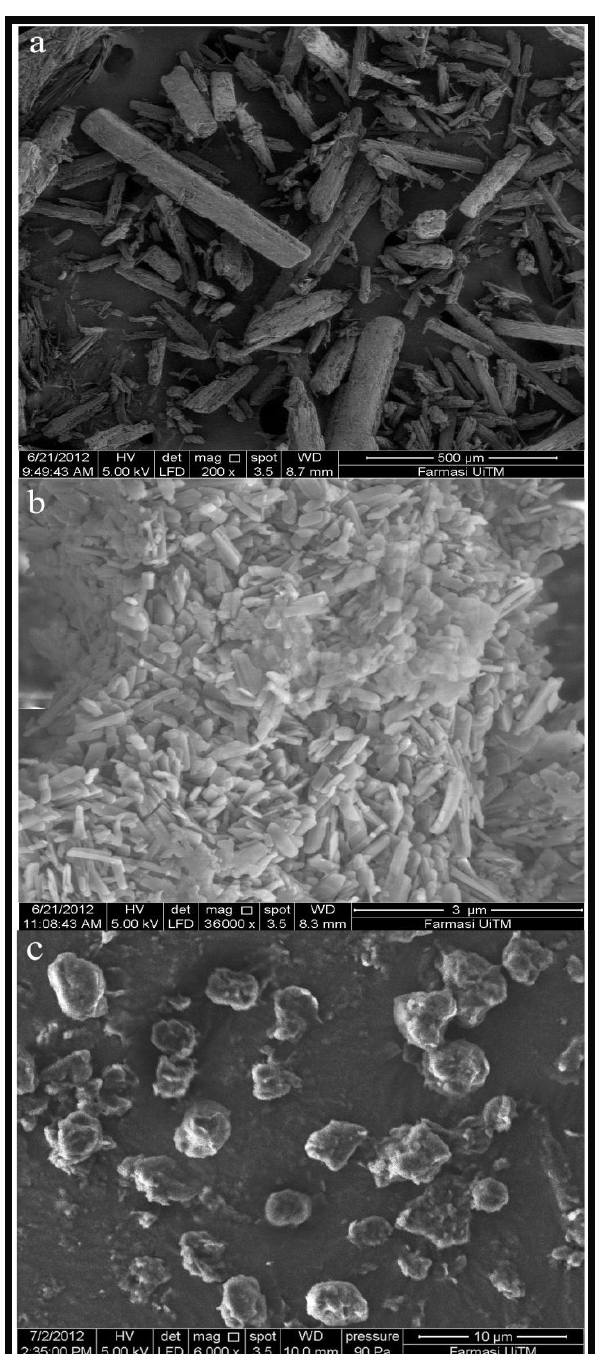
Figure 13: Scanning electron microscopy images of TP ( a), TP – NPs (b) and F